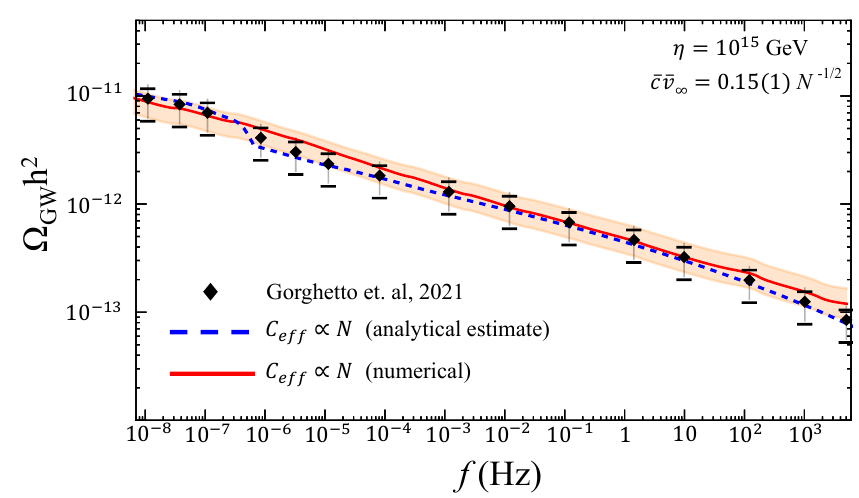
Figure 15 . GW spectrum in the radiation dominated epoch assuming a non-scaling solution ( ξ = 0 . 24(2) N + 0 . 2 ): a comparison between the result with our assumption/method and that obtained in the recent simulation work [49]. The data points with error bars are taken from [49]. The blue dashed curve is based on our analytical estimate eq. (5.6). The red curves with shadowed uncertainty band is based on our numerical calculation of eq. (3.4) with linear growth of C Further details are given in the main